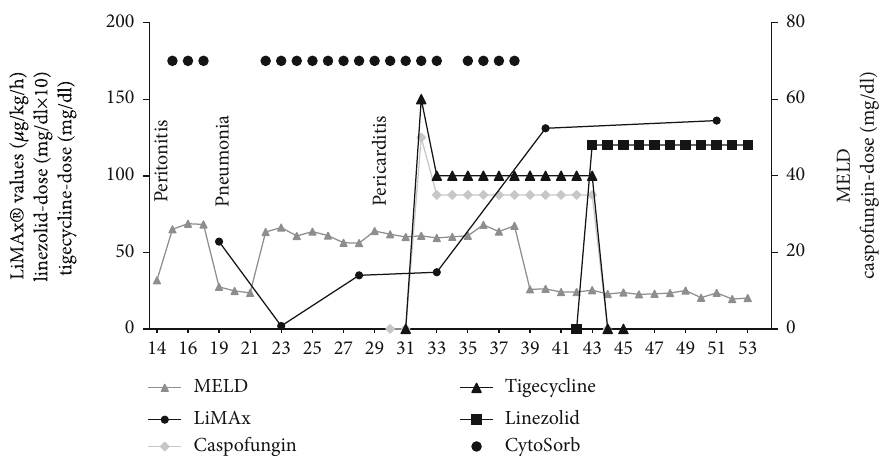
Figure 1: LiMAx® values in comparison to the MELD-Score calculated from conventional liver parameters over the course of treatment and the caspofungin-, tigecycline-, and linezolid-dose administered. Note that CVVHD in combination with CytoSorb® hemoadsorption was restarted at hospital day 22. Linezolid dose should be multiplied by a factor of ten for reasons of better